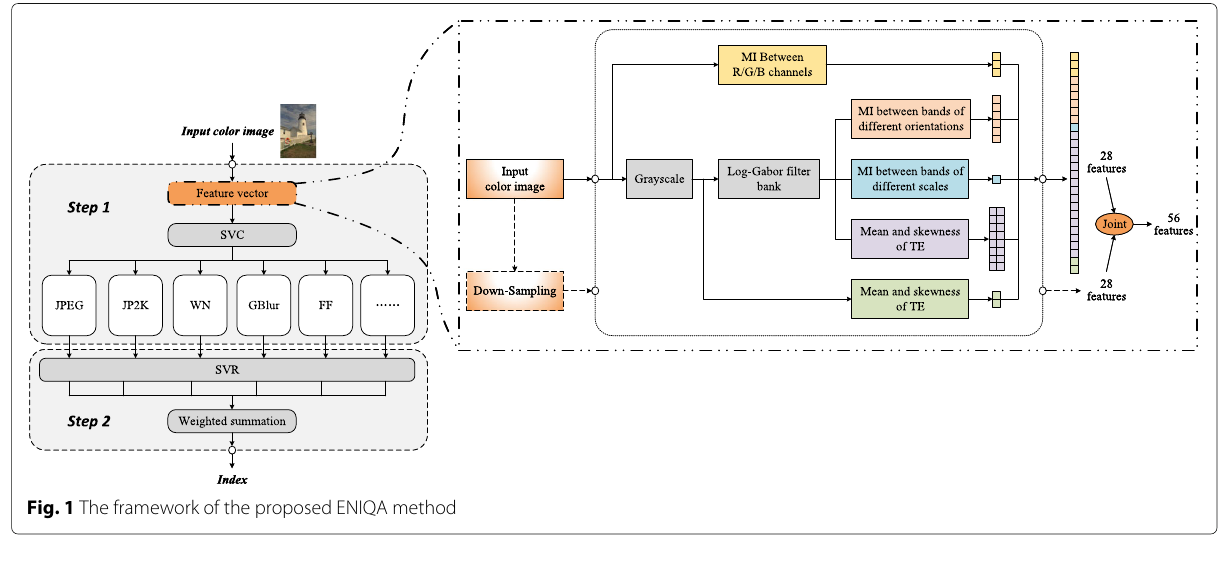
2.1 Two-dimensional entropy Image entropy is a statistical feature that reflects the average information content in an image. The one- dimensional entropy of an image represents the informa- tion contained in the aggregated features of the grayscale distribution in the image but does not contribute to the